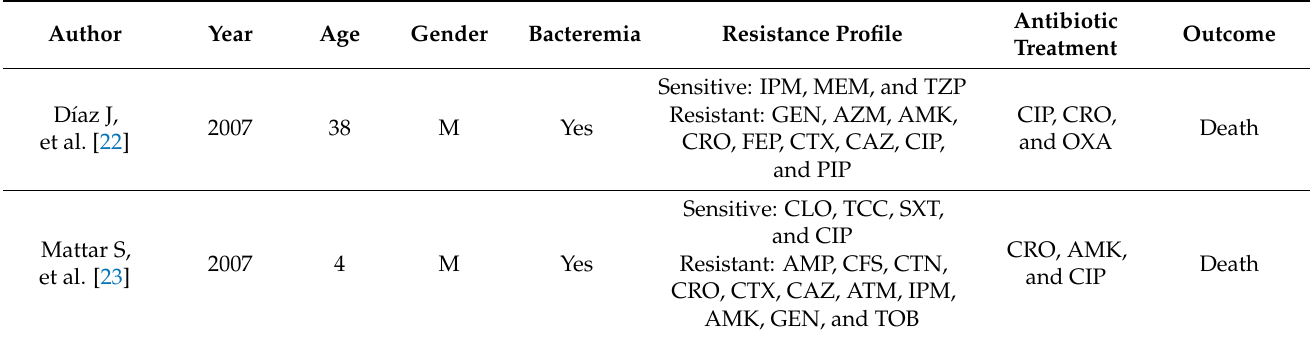
Table 3. Chromobacterium violaceum infections reported in